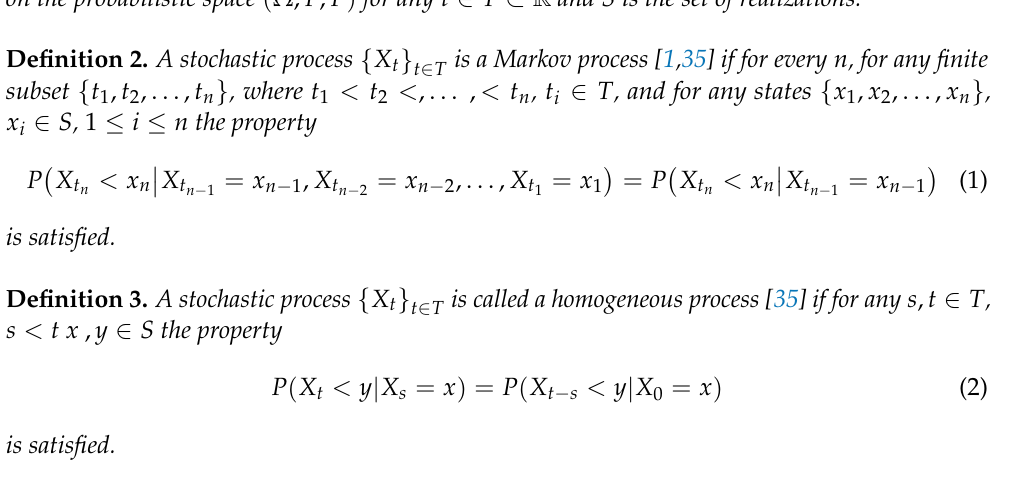
Figure 3. Tires stored in the case study company. Source: Photo taken during the research.